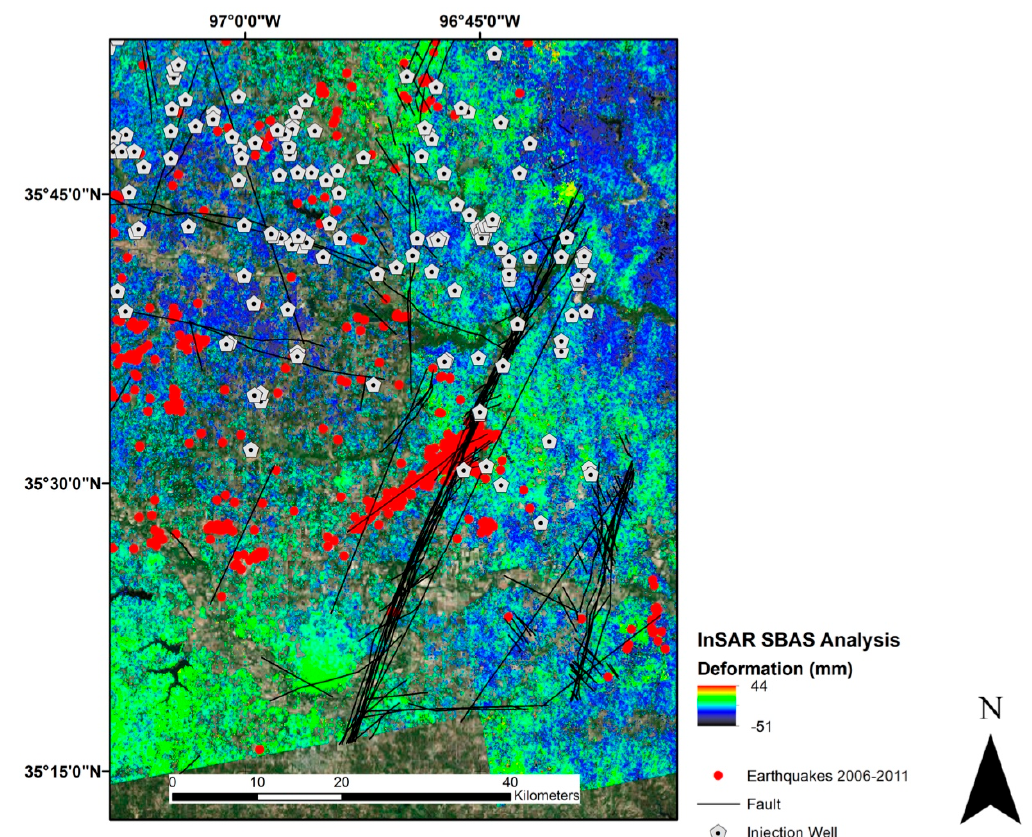
Figure 8. Area of Interest Two- Wilzetta Fault Zone, Meeker–Prague Fault Splay. Figure shows total deformation for InSAR analysis from 2006–2011. Location of faults in black, injection well inventory in grey, and 2.9 M w or greater earthquakes in red. Earthquake data is for the time period coincident with InSAR analysis. All deformation is measured in LOS. Negative values represent movement away from the satellite, whereas positive values indicate movement towards the satellite.